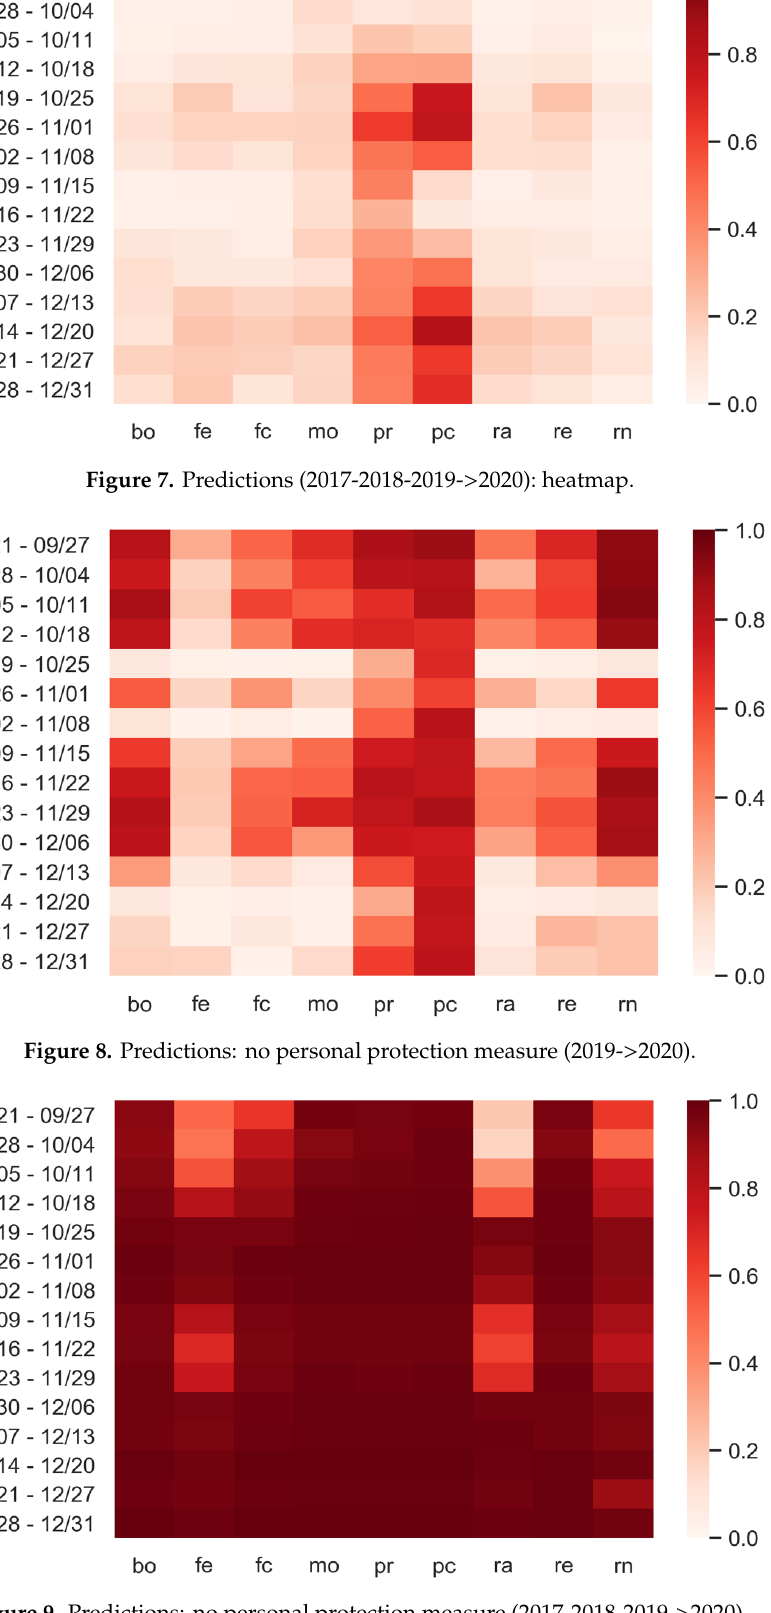
Figure 9. Predictions: no personal protection measure (2017-2018-2019->2020).